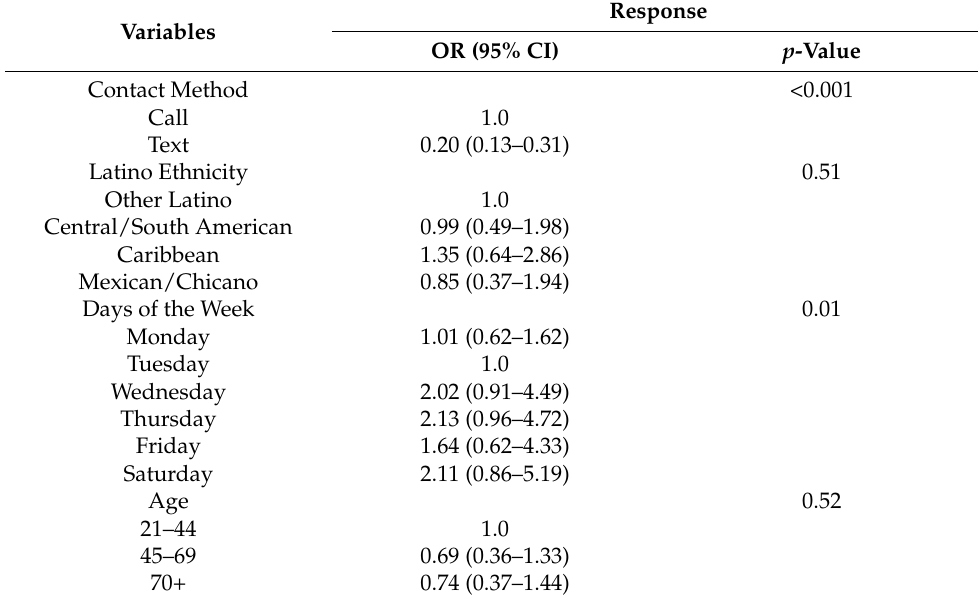
Table 3. Logistic regression model of responses to recruitment